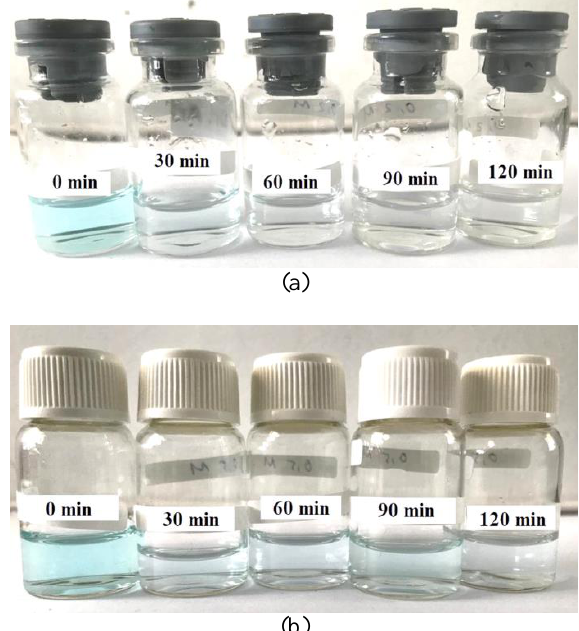
Fig. 5. The degradation process of MB by (a) Z-200 and (b) Z-500 samples Figure 6(a) is the curve of absorption of degradation product of ZnO sample at λ = 662 nm versus time.